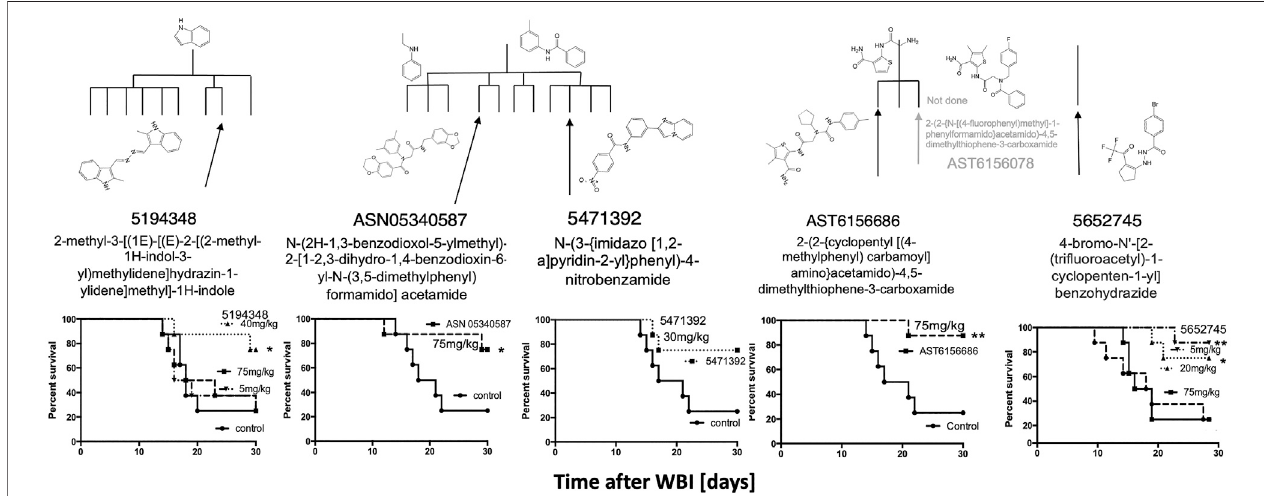
FIGURE6| FiveotherHTS invitro “ hits ” mitigatedH-ARSinC3Hmicegivenoncedailyfor5 dstarting24 hafterLD70/30dosesofWBI(Cs).* p < 0.05,** p < 0.01, *** p < 0.001.